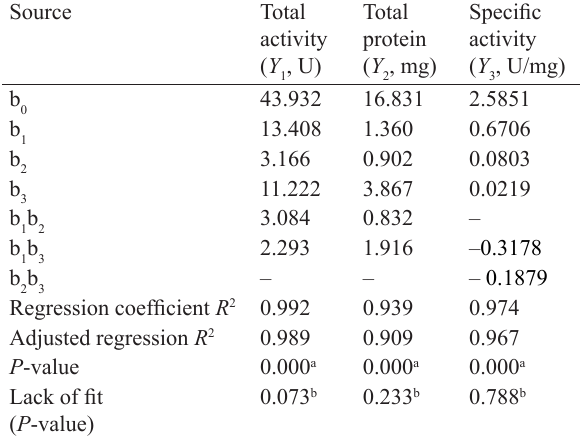
Table 3 M ain and interaction effects of pH ( X